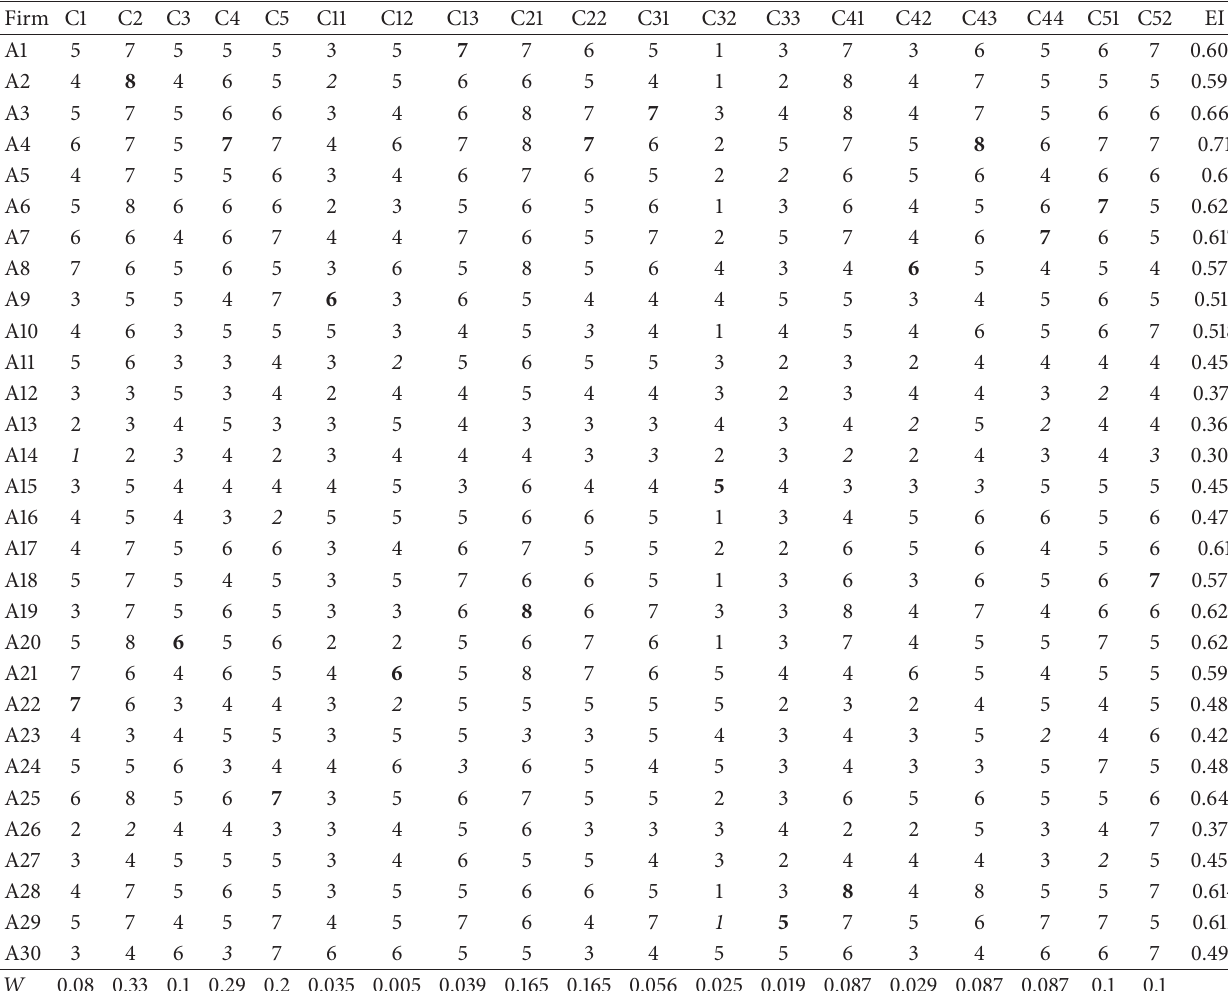
Table 7: The aggregated EI scores of the firms.